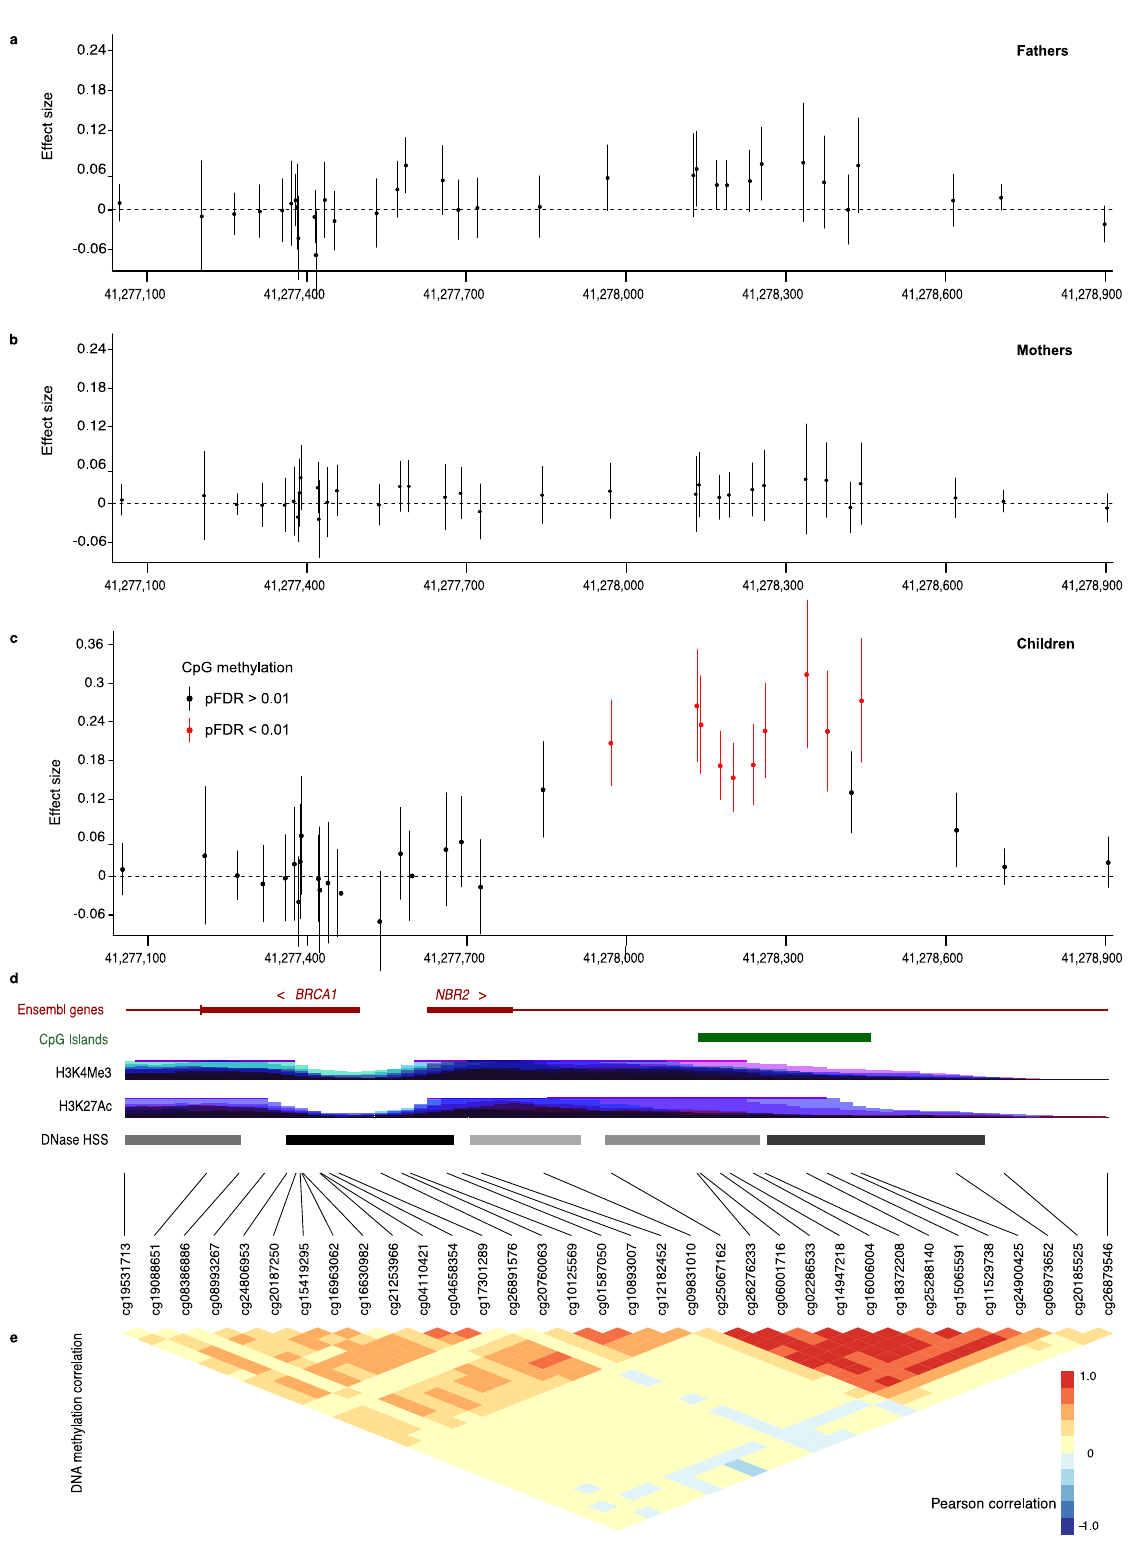
adjusted for parental DNA methylation at each CpG site. In addition, we analyzed DNA methylation in naturally conceived newborns using time to pregnancy (TTP) as a measure of parental fertility. A linear mixed model was fi tted to investigate the association between DNA methylation in the newborns with TTP as an ordinal variable, adjusting for maternal age, maternal smoking, maternal BMI, child sex, parity, and plate ID. Further, we examined the differences in the two most con- trasting groups: TTP <3 months to TTP> 12